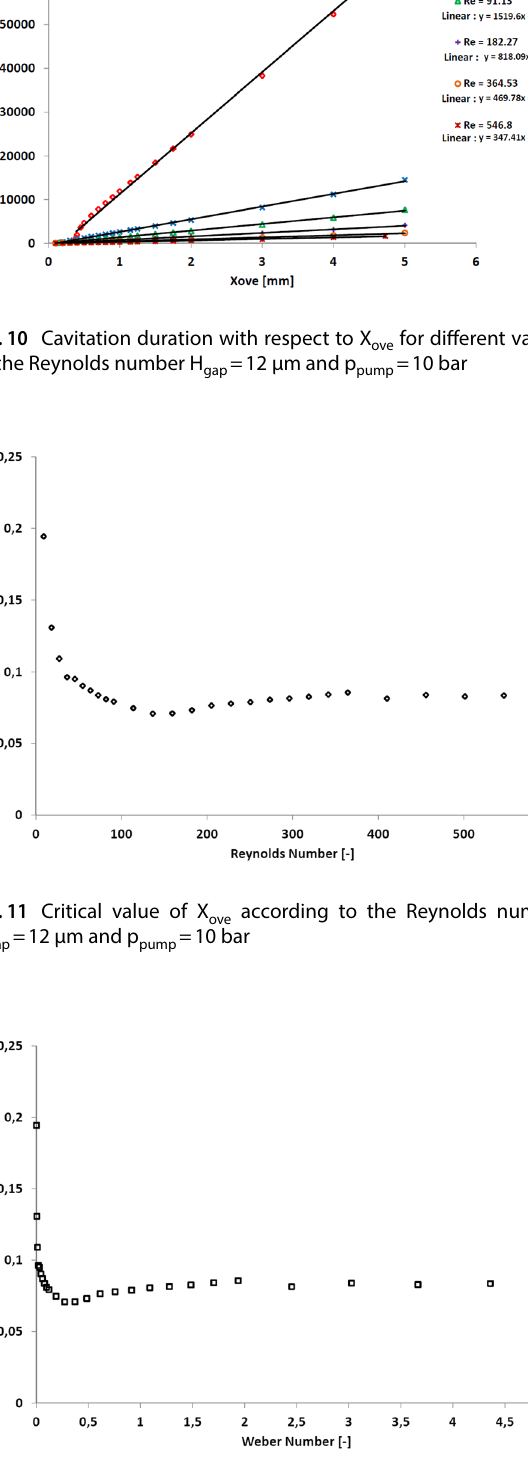
according to the Weber number ove = 10 pump